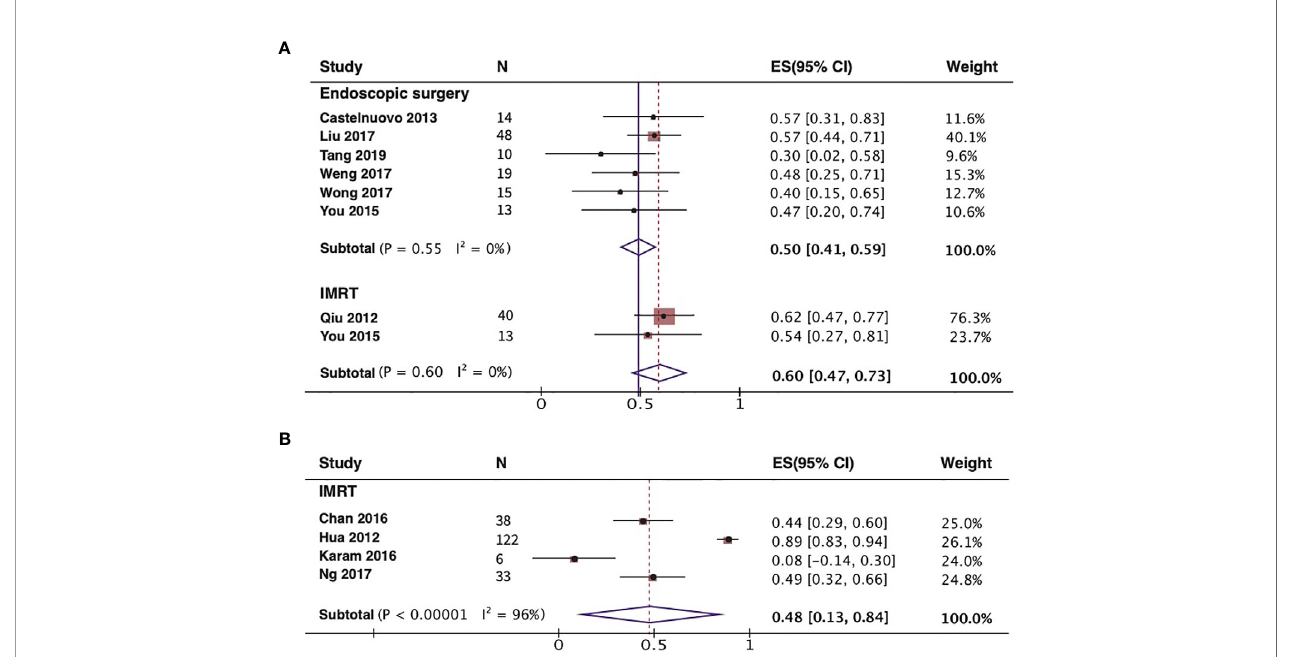
FIGURE 3 | Forest plot of DFS and LCR in the endoscopic surgery and/or IMRT group with recurrent rT3-4 NPC. (A) Meta-analysis of 2-year DFS rates. (B) Meta- analysis of 3-year LCR for IMRT group. NPC, nasopharyngeal carcinoma; IMRT, intensity-modulated radiotherapy; DFS, disease-free survival; LCR, local control